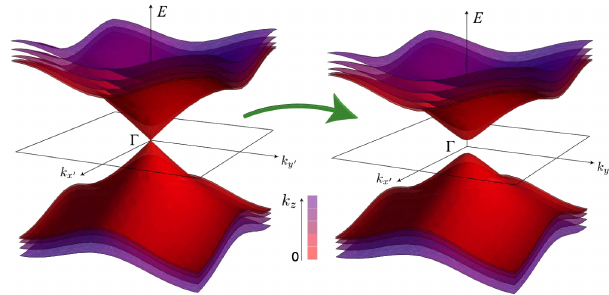
FIG. 10. Dirac mass gap 2 j Δ j introduced by AFTR and C 2 symmetry-breaking dimerization Δ ¼ Δ 1 þ i Δ 2